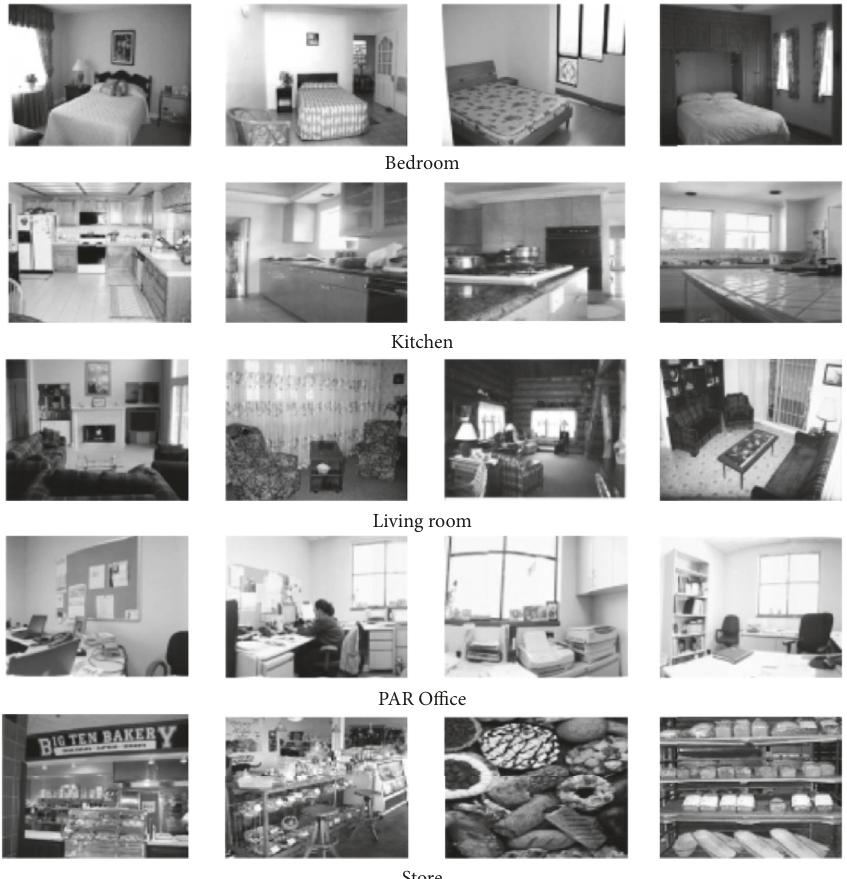
Figure 3: Some examples of indoor scene images in Scene 15 dataset.